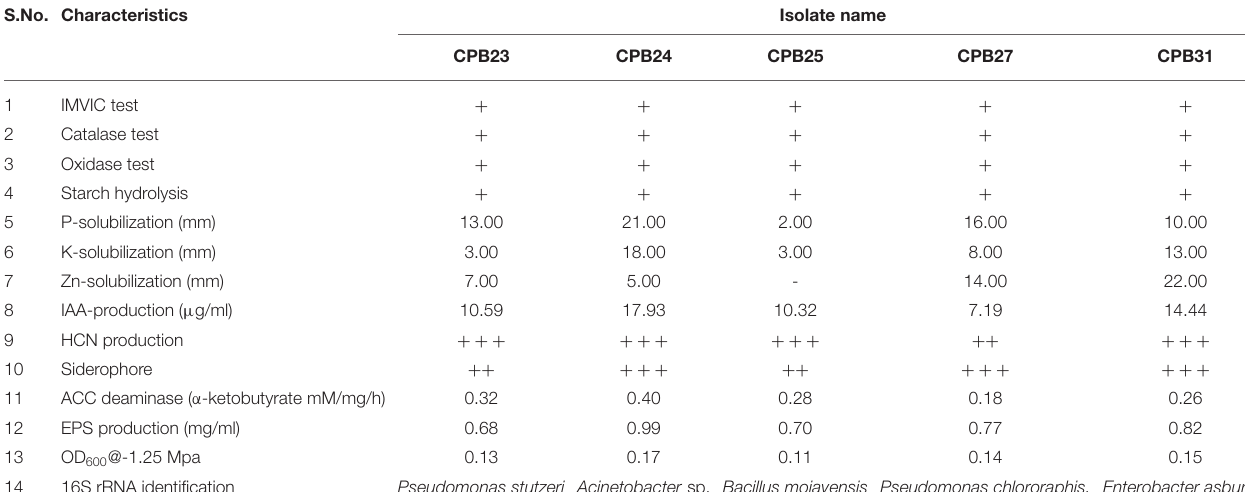
TABLE 1 | Biochemical and plant growth attributes: physiological/biochemical responses of efficient isolates and production of EPS, ACC deaminase, IAA, HCN under in vitro conditions. S.No. Characteristics